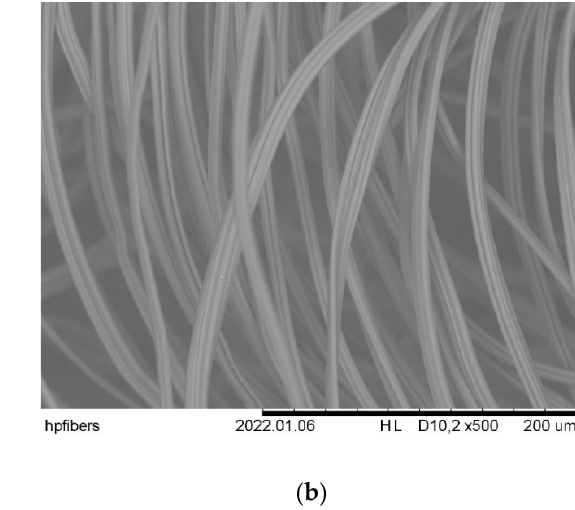
Figure 22. Regenerated cellulose fiber types Danufil (conventional cellulosic fiber) and Danufil BF (flame-retardant cellulosic fiber with silica content)—( a ) EDS spectra of Danufil and Danufil BF in comparison; ( b ) SEM image of Danufil BF.